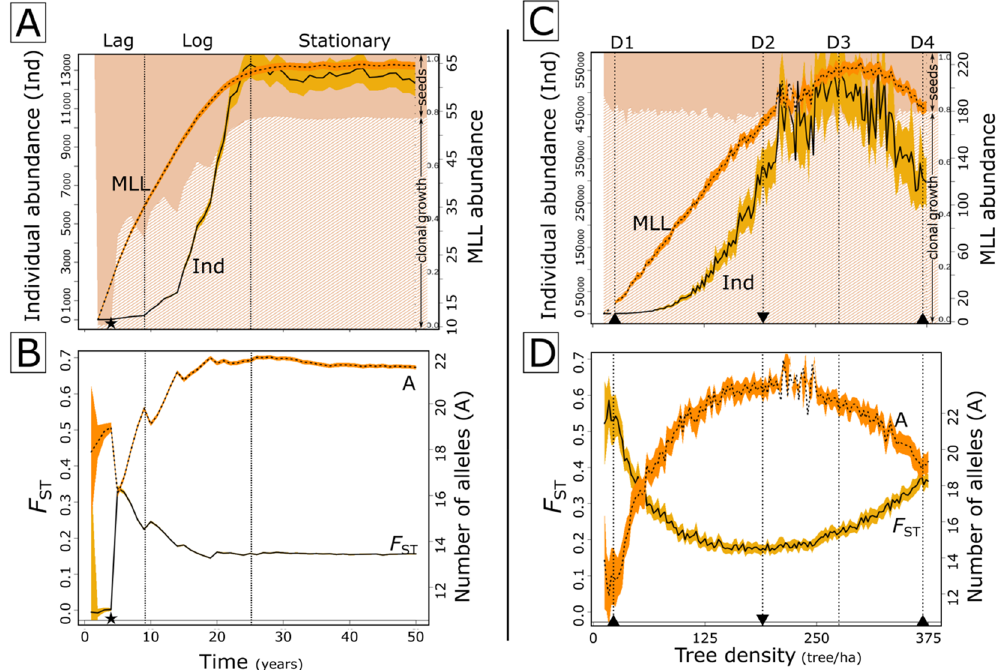
Figure 4. Patterns obtained from multiple simulations of the spreading of Tillandsia recurvata populations in the empirical static landscape (see Fig. 1) over 50 years ( A , B ), and in static landscapes with varying tree densities after 20 years of simulations ( C , D ). ( A ) and ( C ) show the abundance of individuals (solid line) and multi-locus lineages (MLLs, dotted line), as well as the clonal-growth proportion (lighter background). ( B ) and ( D ) show the pairwise subpopulation differentiation ( F ST , solid line) and the average number of alleles per subpopulation (dotted line). Yellowed areas around lines represent the 95% confidence intervals of each variable in a total of 2500 ( A , B ) and 7000 ( C , D ) simulations. In ( A ) and ( B ), “Lag”, “Log”, and “Stationary” phases are delimited by vertical lines. In ( C ) and ( D ), vertical lines highlight turning points in the individual abundance and F ST of T. recurvata populations (D1–D4). Stars highlight the 4th simulated year, when the first arriving seeds reach maturity. Down and up arrowheads highlight tree densities with the lowest and highest F ST ,